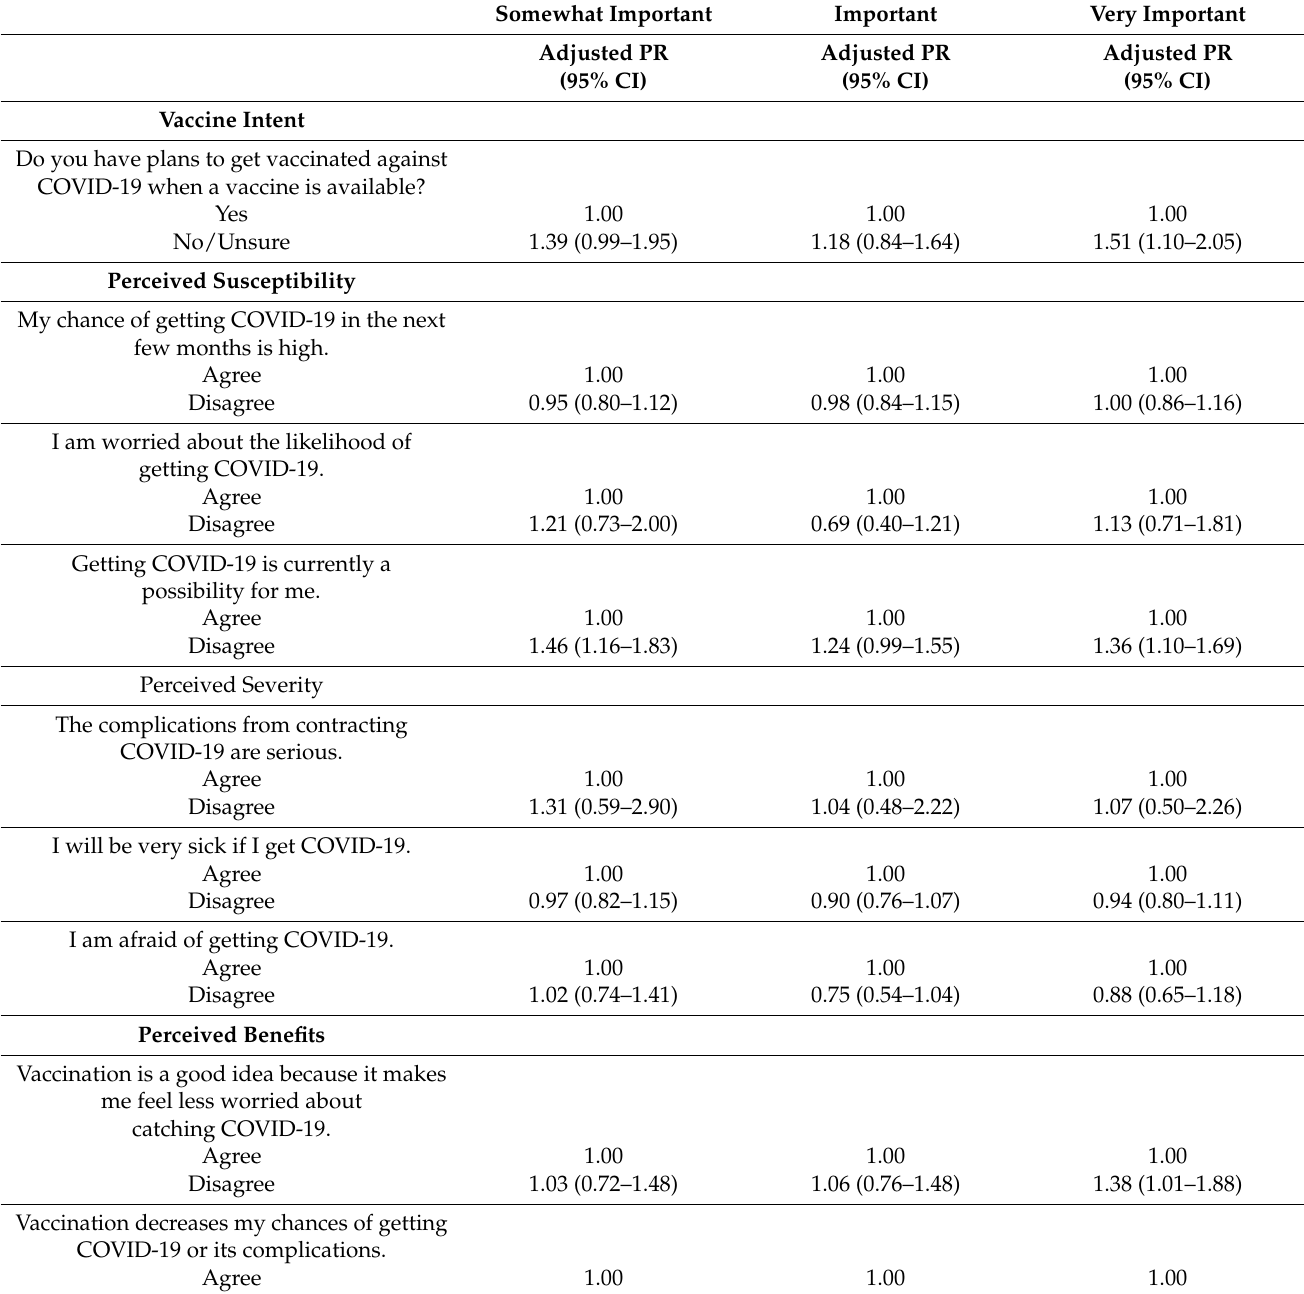
Table 3. COVID-19 vaccine hesitancy and predictors by importance of religion using logistic regression